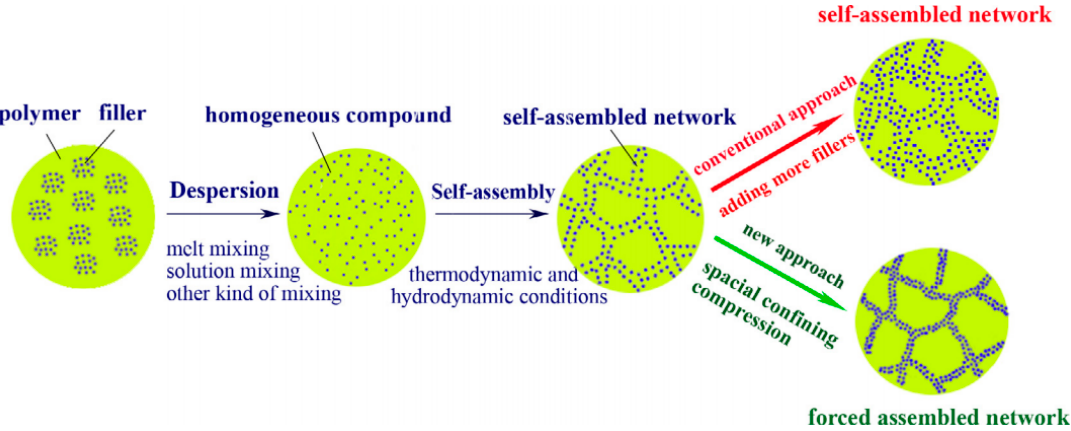
Figure 5. Scheme of technological pathway of SCFNA and conventional compounding method (Reproduced with permission